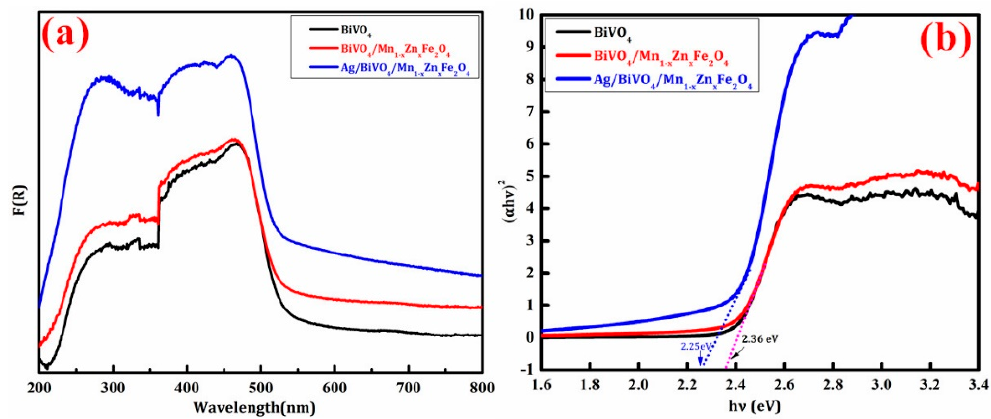
Figure 5. ( a ) UV-vis diffuse reflection spectra of products and ( b ) plot of (Ah υ ) 2 versus photon energy (h υ ) according to the UV-vis DRS.